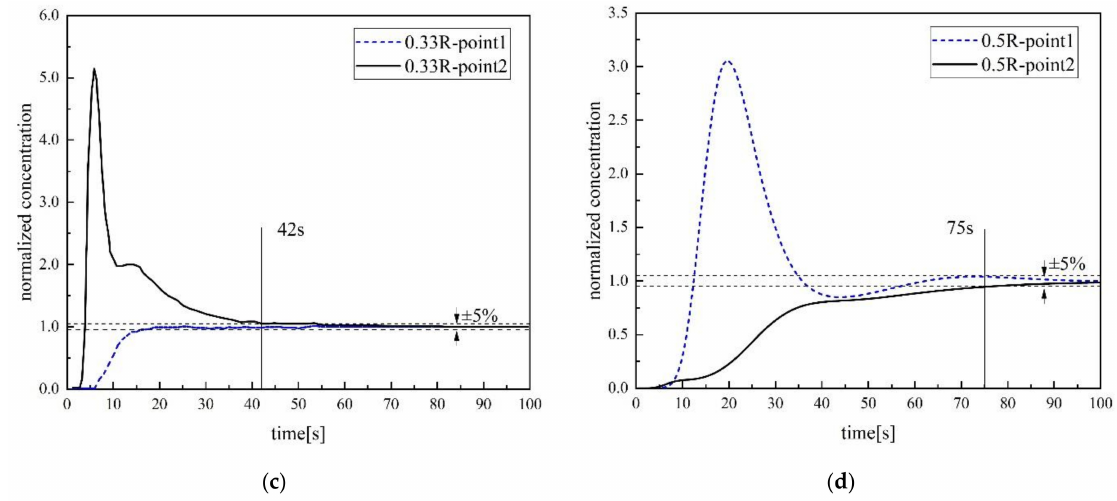
Figure 11. Normalized concentration changing with time at different gas injection position; ( a ) 0.17R;